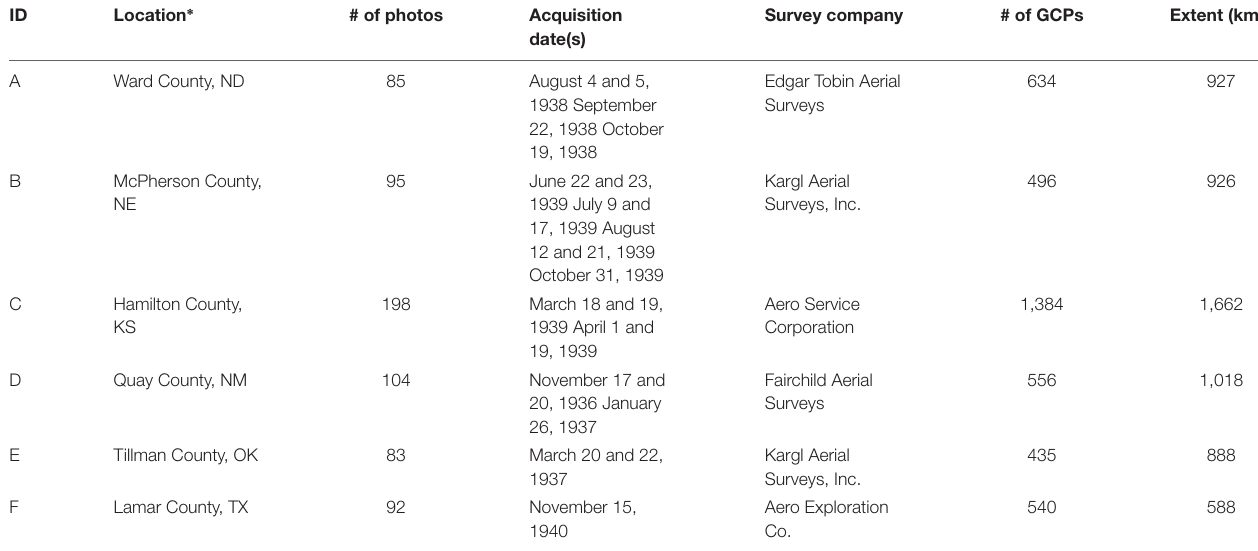
TABLE 2 | Survey details and spatial extent of photos reproduced for this study from United States Department of Agriculture contracted surveys (with Figure 6 ).